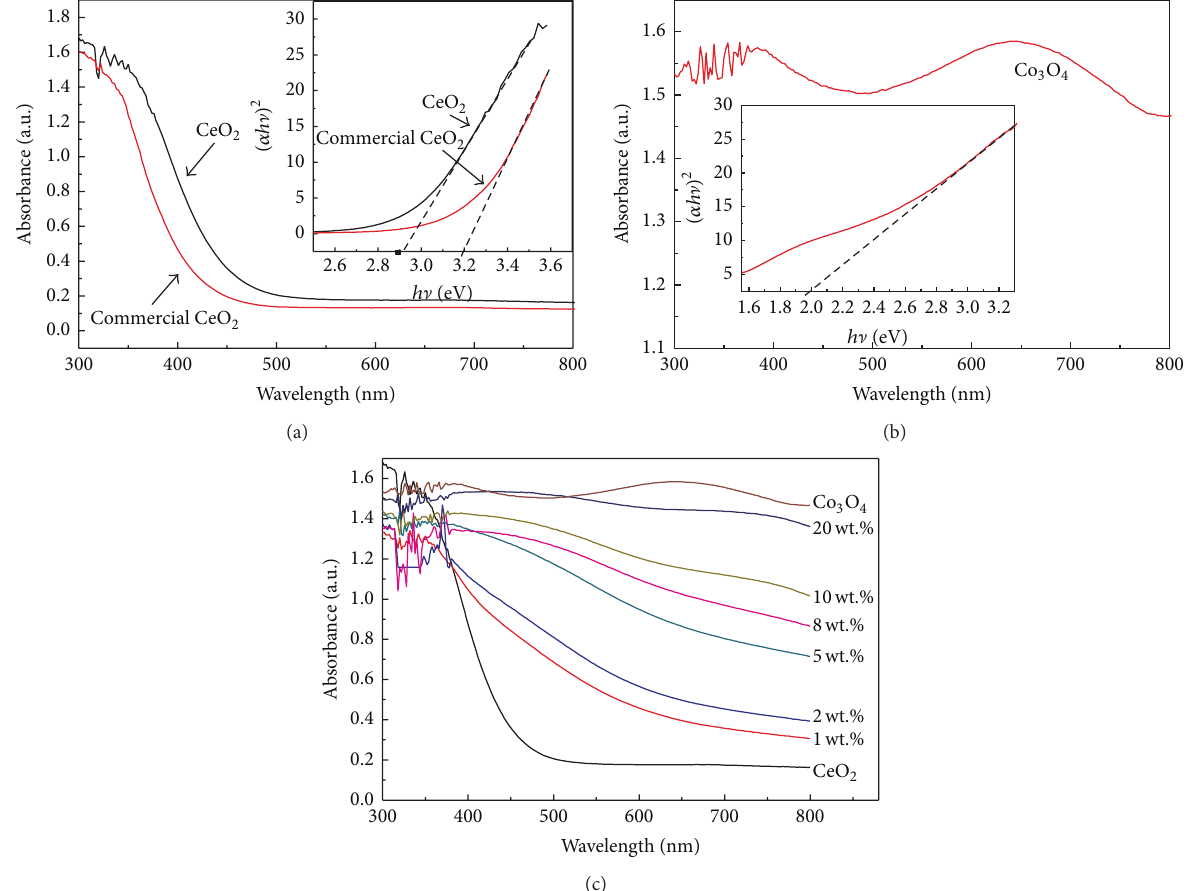
Figure 3: UV-vis absorption spectra of CeO 2 and commercial CeO 2 catalyst (a), Co 3 O 4 (b), and the Co 3 O 4 /CeO 2 photocatalysts (c).